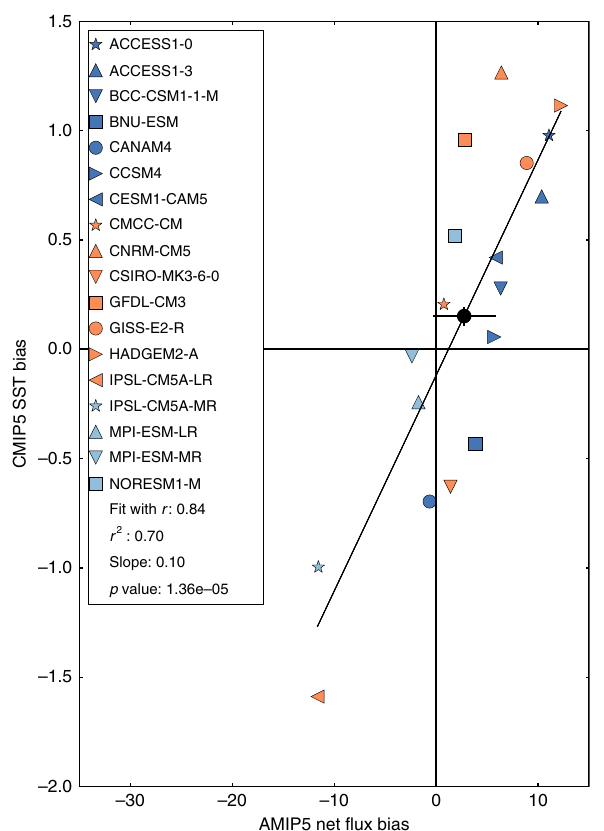
Fig. 1 Linear regression of CMIP5 SST biases on AMIP5 net fl ux biases averaged over 40 – 60°S. These analyses were undertaken using the 18 models that provided suitable diagnostics for both CMIP5 and consistent AMIP5 experiments (see Methods and Supplementary Table 1). Our observational product uncertainty estimates are ~ 3 Wm − 2 for net fl ux and ~ 0.04 K for SST. Observational product errors do not affect the regression slope, correlation or p values. However, the position of points for individual models and regression intercepts do include a contribution from observational error. The multi-model mean values are plotted with a solid black circle with a cross indicating their estimated observational uncertainties. The small multi-model mean bias estimates compared to the variations in the biases suggest that common structural errors in these parameters are not dominant for CMIP5 SST and AMIP5 net fl ux biases in this region and set of